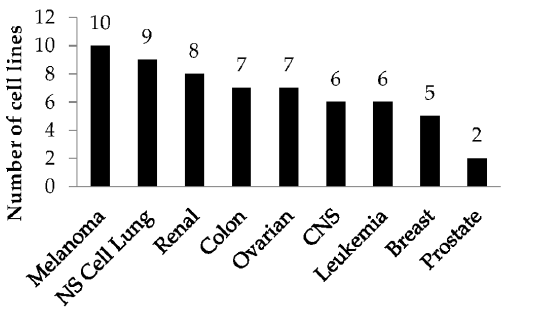
Figure 1. Distribution of 438 cell lines by organs and tissue.